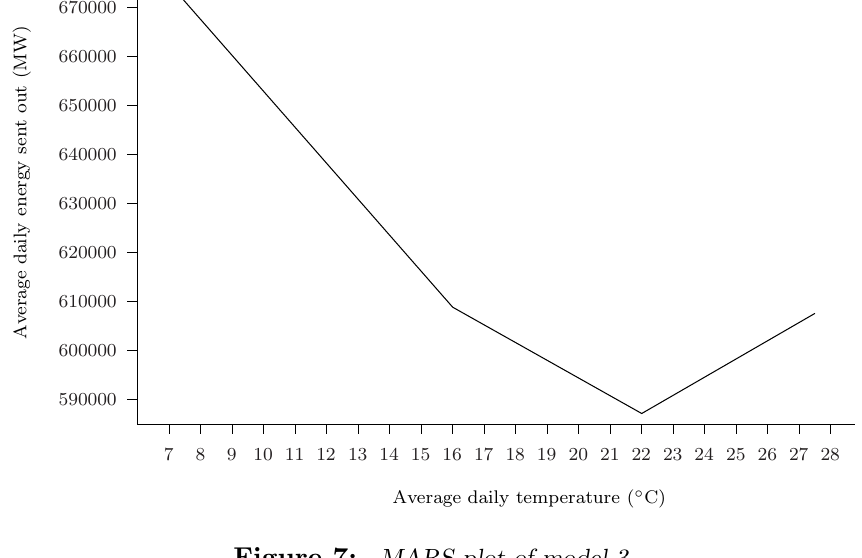
Figure 7: MARS plot of model 3.